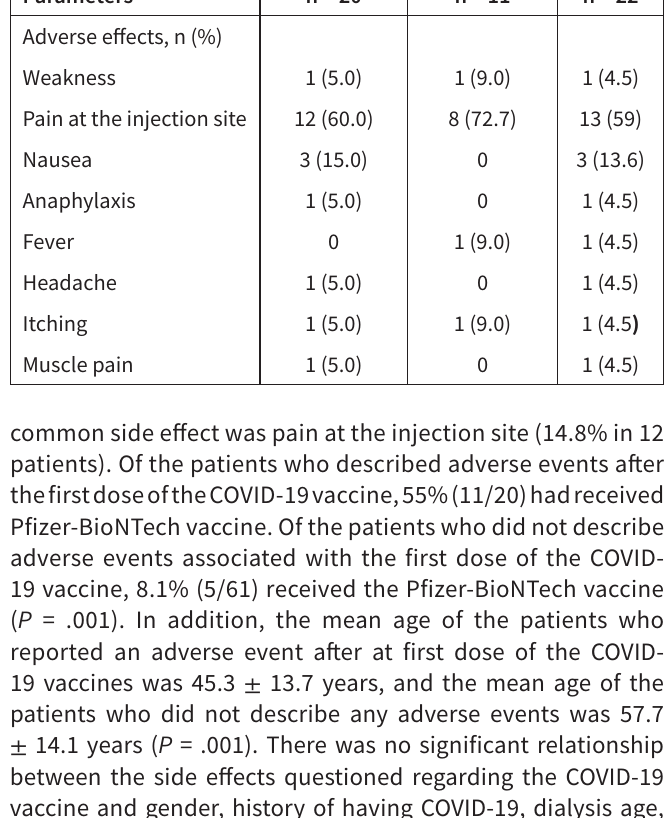
Table 5. Distribution of Adverse Effects After COVID-19 Vaccines Parameters